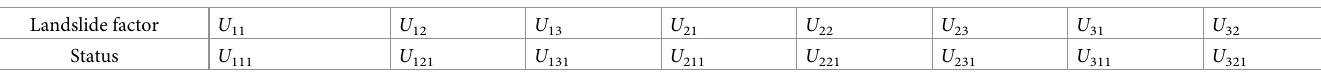
Table 1. State data for the induced landslide environmental condition factors in the selected computational unit. Landslide